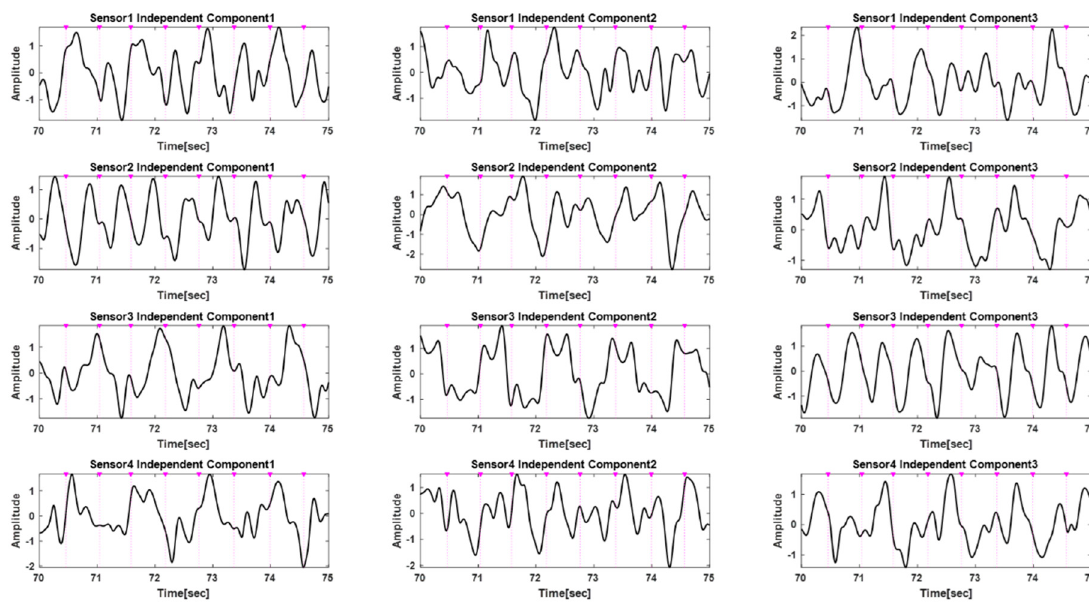
Figure 7. ICA components of 12 ‐ channel PPG signals.